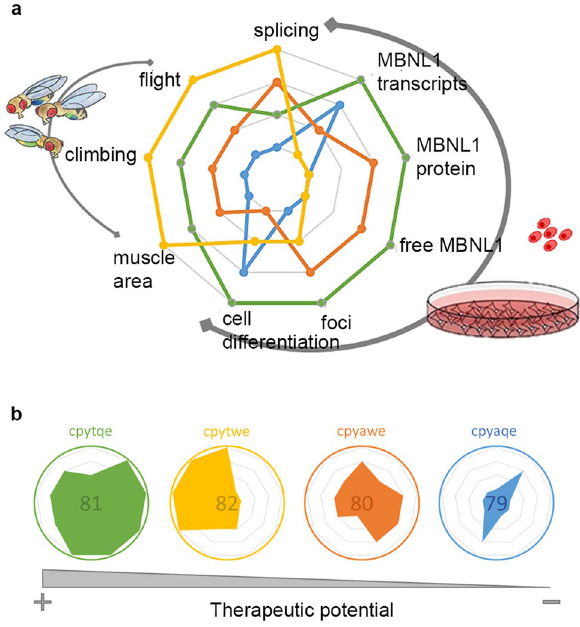
Figure 8. Overall assessment of candidate peptides. Rescues obtained with each peptide (according to the color code shown in b ) were converted into a semiquantitative score that reflected the quality of rescue achieved in each of the experimental systems represented (Drosophila and cell model). Scores were inserted into a spider chart, where the internal most polygon indicates no rescue and the outermost indicates full rescue ( a ). The four peptides were sorted according to their therapeutic potential in decreasing order from left to right ( b ). Created with